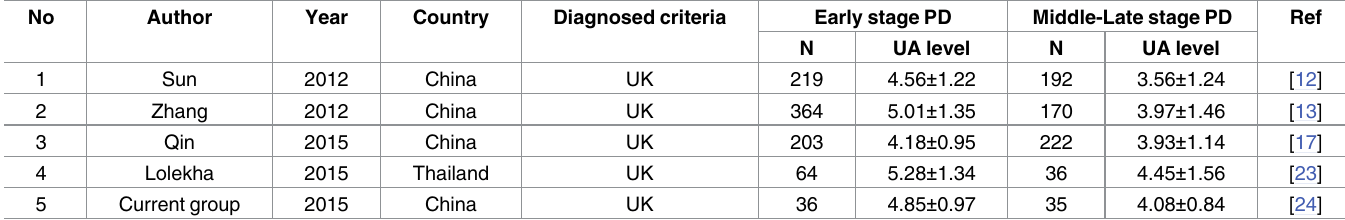
Table 3. Summaryof studies included in the H&Y scale subgroup